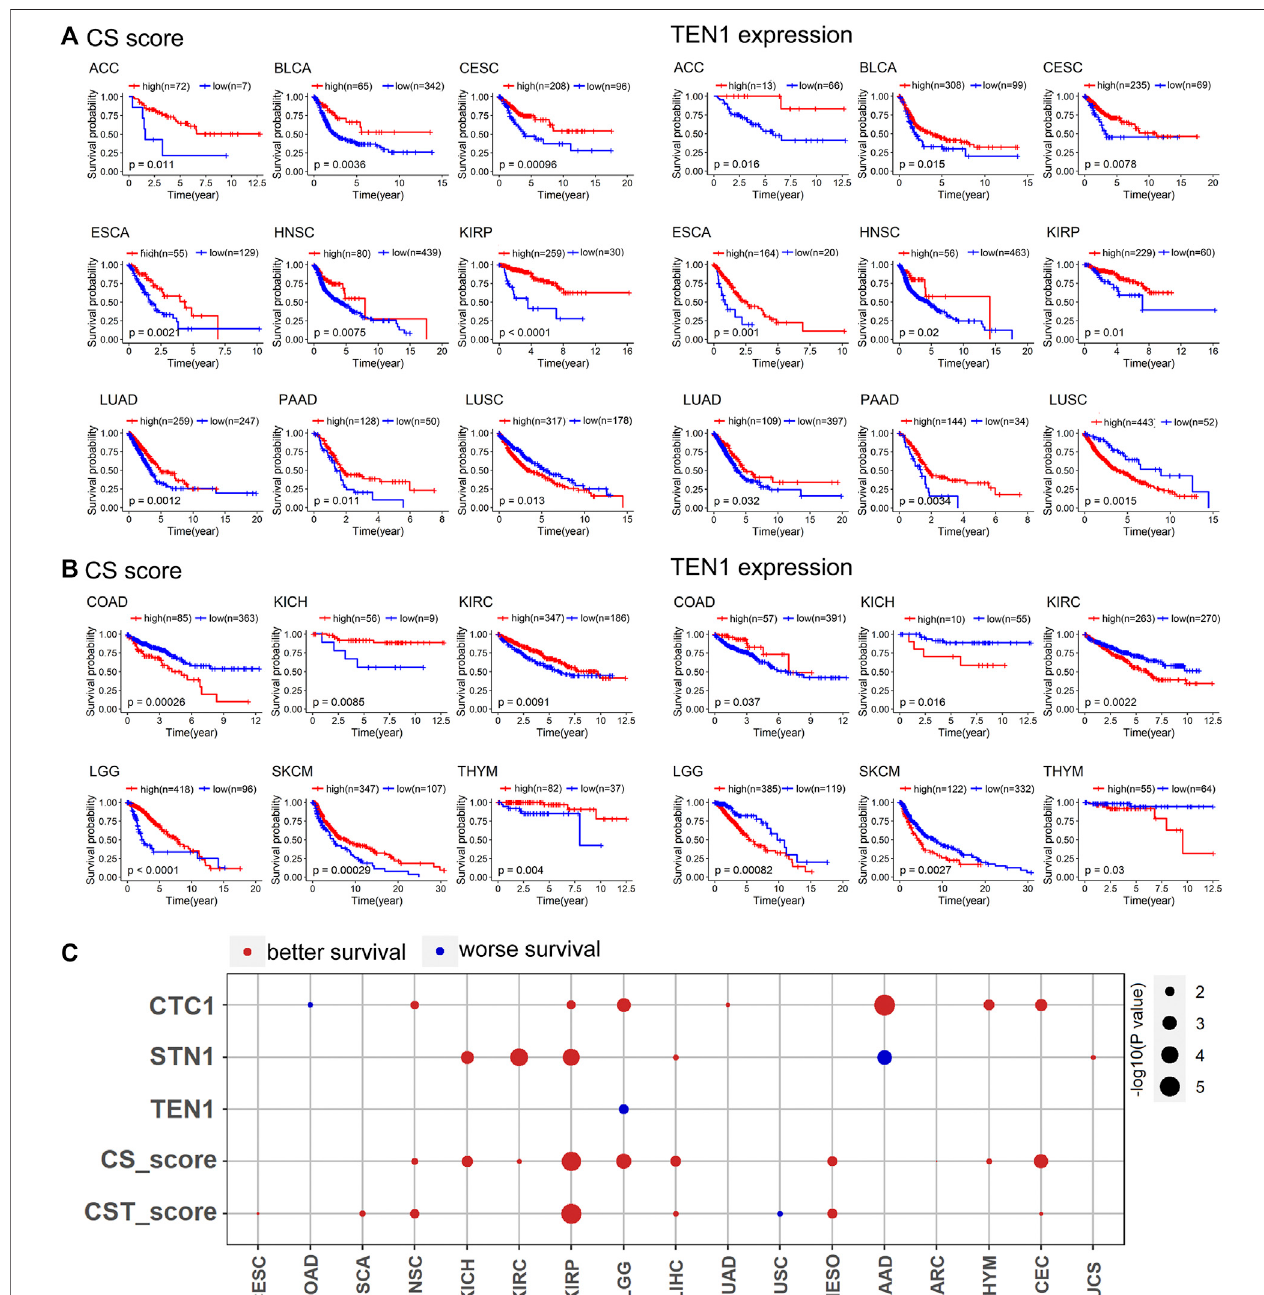
FIGURE3| CTC1andSTN1predictbettersurvival: (A) CSscoreandTEN1expressionwereconsistentinpredictingtheprognosisofninecancertypes.AhighCS scoreandhighTEN1expressionwerepositivelycorrelatedwithoverallsurvival,exceptforLUSC.Statisticalanalysiswasperformedusingthelog-ranktest. (B) CSscore and TEN1 gene expression were not consistent in predicting the prognosis of six cancer types, including COAD, KICH, KIRC, LGG, SKCM, and THYM. Statistical analysis was performed using the log-rank test. (C) Summary of COX regression correlation of CST with survival. Red indicates better survival, and blue indicates worse survival. Only signi fi cant dots with p value < 0.05 are shown. The size of the dot is proportional to the – log10( p value).